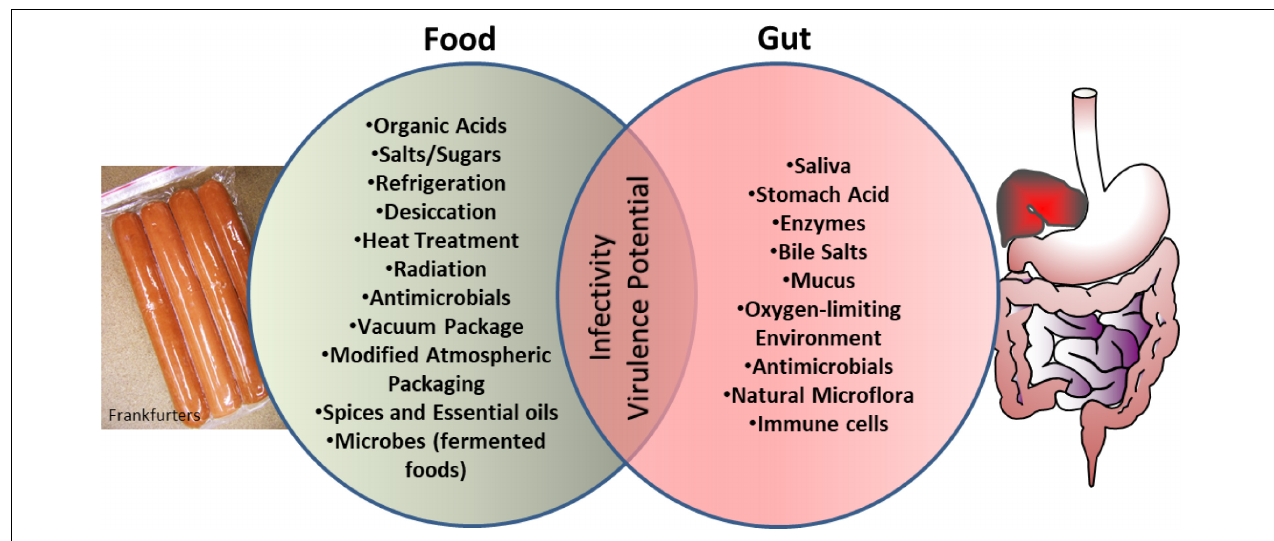
FIGURE 1 | Schematics showing microbial exposure to shared stress environment between food processing conditions and human gut, which prime microbes for enhanced virulence and infectivity.